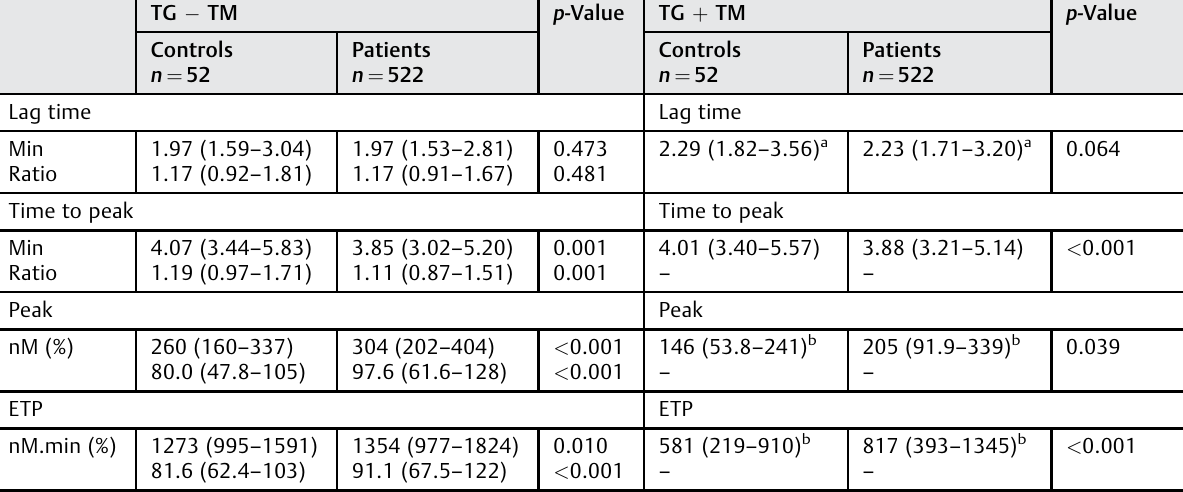
Table 2 Thrombin generation parameters obtained in the absence and presence of thrombomodulin in patients compared with